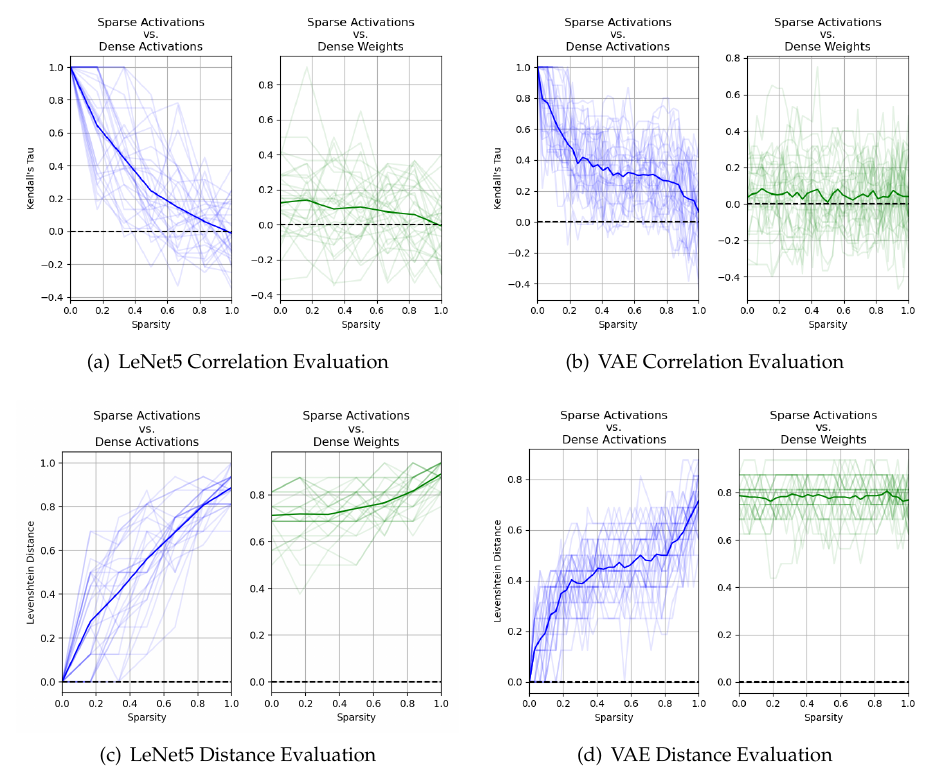
Figure 4. As discussed in Section 3, we evaluate the Kendall coefficient of rank correlation (top row) and the Levenshtein distance (bottom row) over 30 independently trained discriminative models (left column) and generative models (right column). We plot the correlation and distance between r µ r µ in blue, and the correlation and distance between r µ i | s